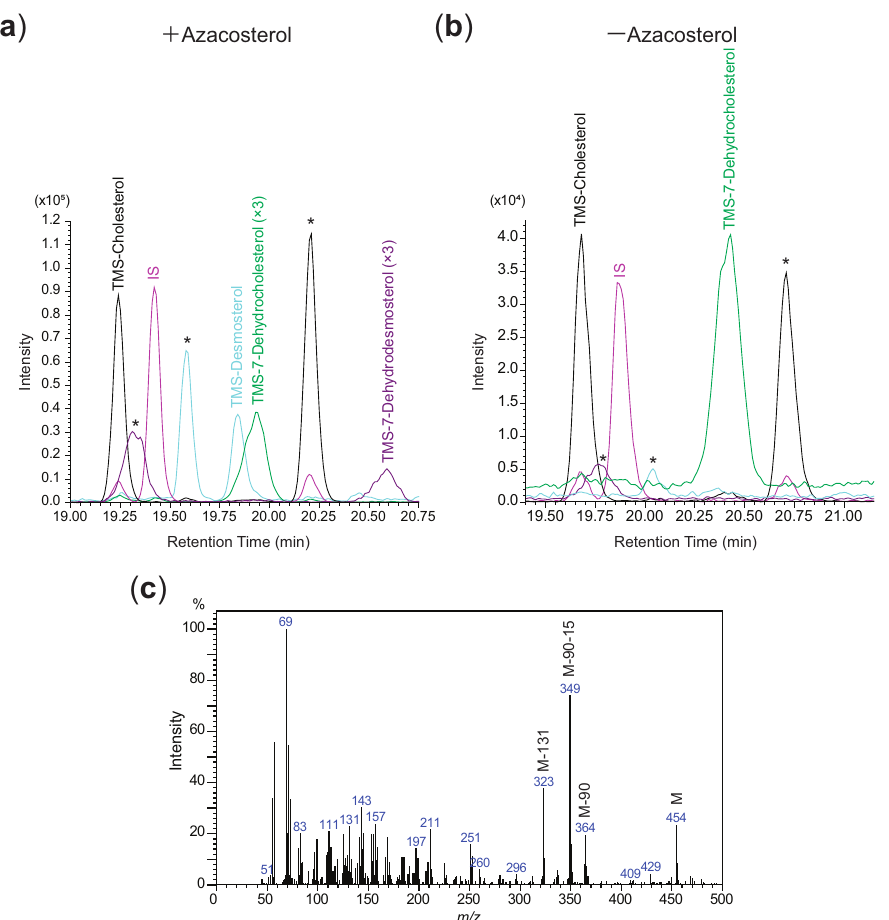
Figure 5. Chromatogram of ions corresponding to TMS-desmosterol ( m/z 343) and TMS-7- dehydrodesmosterol ( m/z 349) detected in anterior midgut of ( a ) crickets fed on diet containing azacosterol and that of ( b ) crickets fed on diet without azacosterol. The number of times the peak was magnified is indicated in the bracket next to the sterol name. ( c ) Mass spectrum of TMS-7- dehydrodesmosterol detected in all anterior midgut samples of crickets in this study ( n = 7). The * indicates the peaks of sterols (Unidentified sterol (RRT = 1.005), TMS-5 α -cholesta-7,22-dien-3 β -ol (RRT = 0.992) and TMS-lathosterol (RRT = 0.961) that were not studied in this